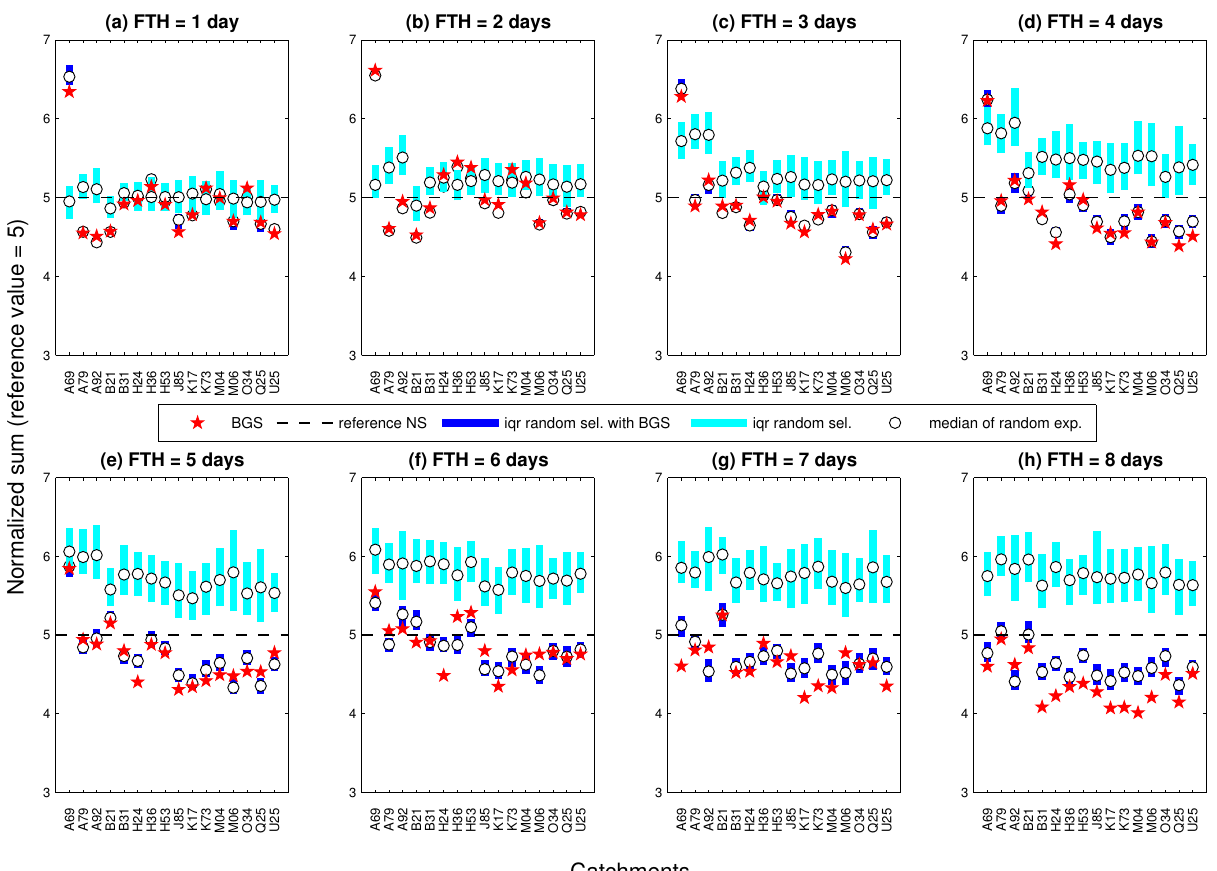
Fig. 4. Evolution of the normalized sum (NS) to evaluate the response sensibility with regard to the interquartile range (iqr) of 200 random experiments in different FTHs following these guidelines: (1) Considering the participation of hydrological models found with BGS-CV (vertical blue bars), and (2) Without regard to any “a priori” participation of hydrological models, i.e. completely random selection (vertical cyan